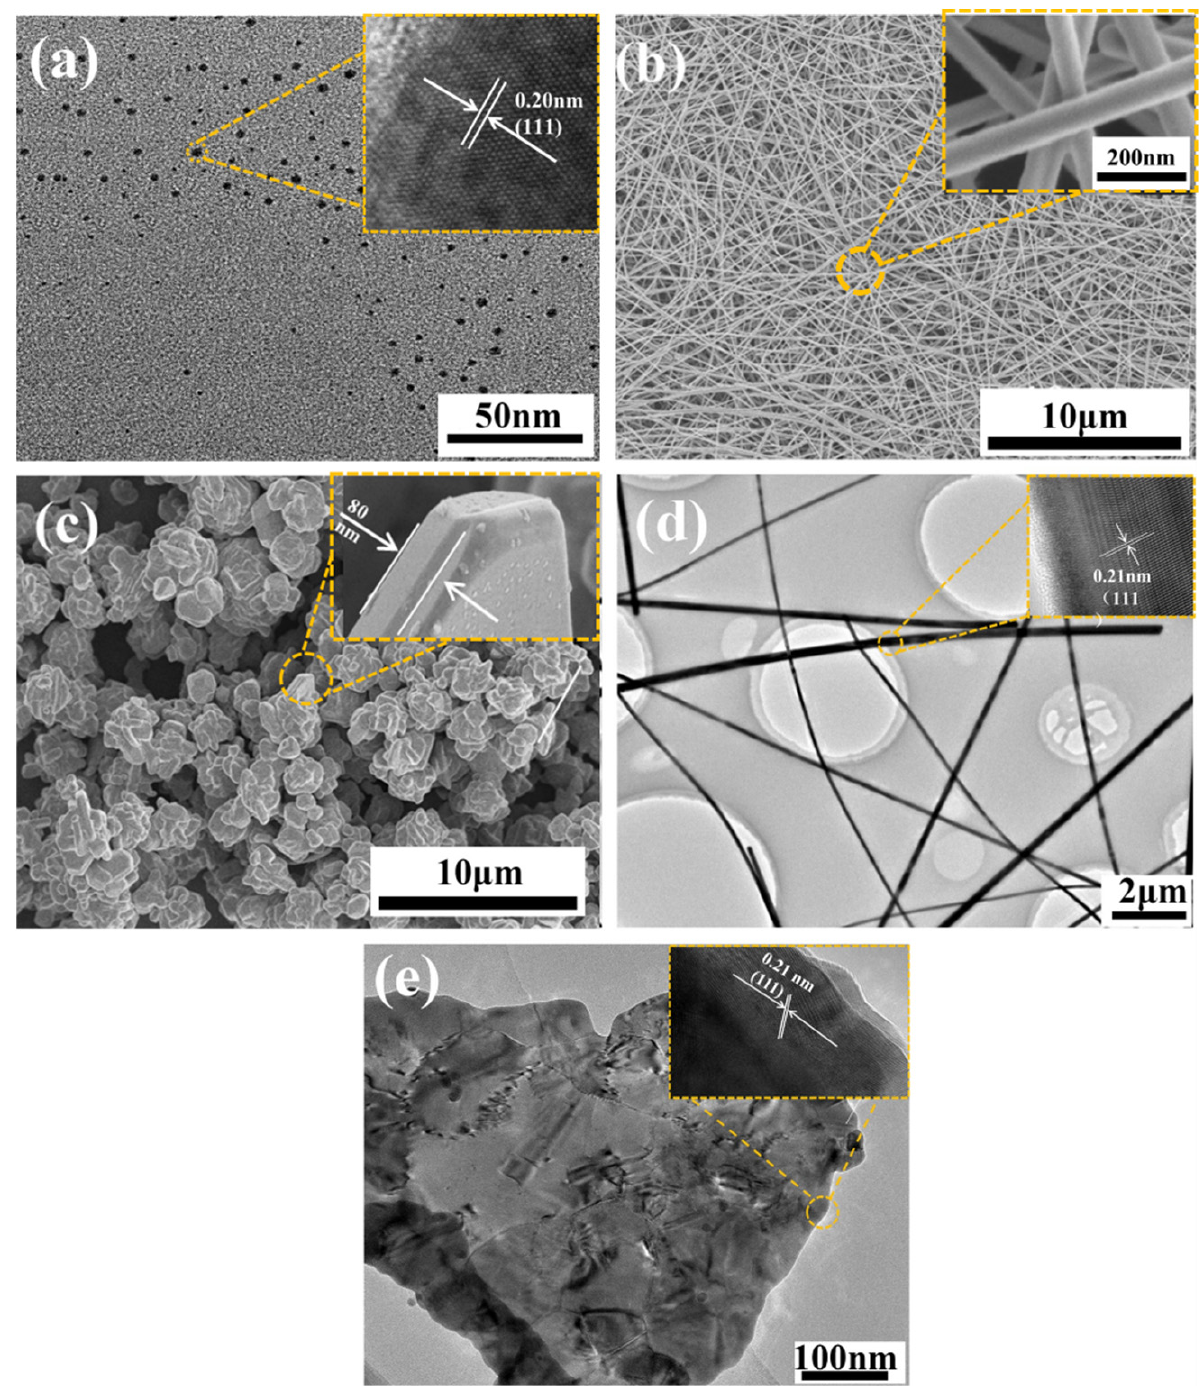
Figure 1. TEM image of ( a ) Ag NPs, SEM images of ( b ) Ag NWs and ( c ) Ag MFs, TEM images of ( d ) Ag NWs, and ( e ) Ag MFs.